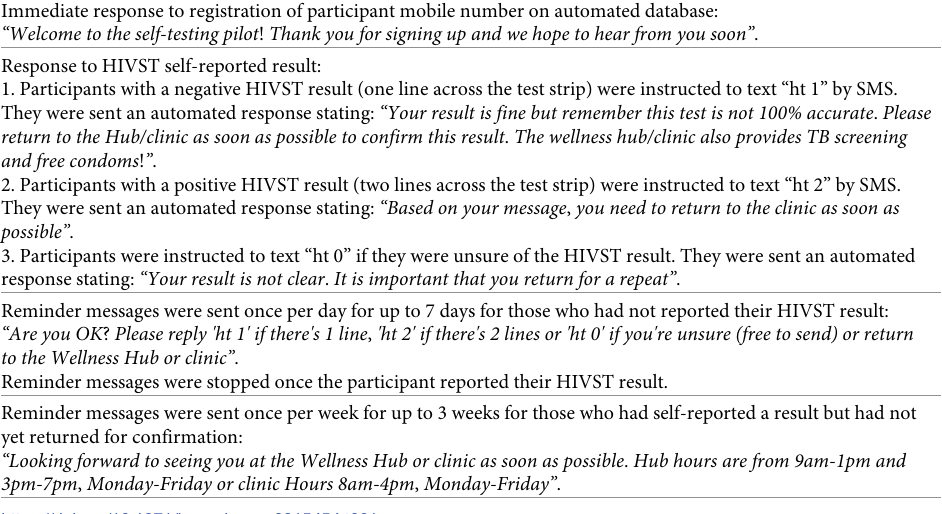
Table 1. SMS responses from automated